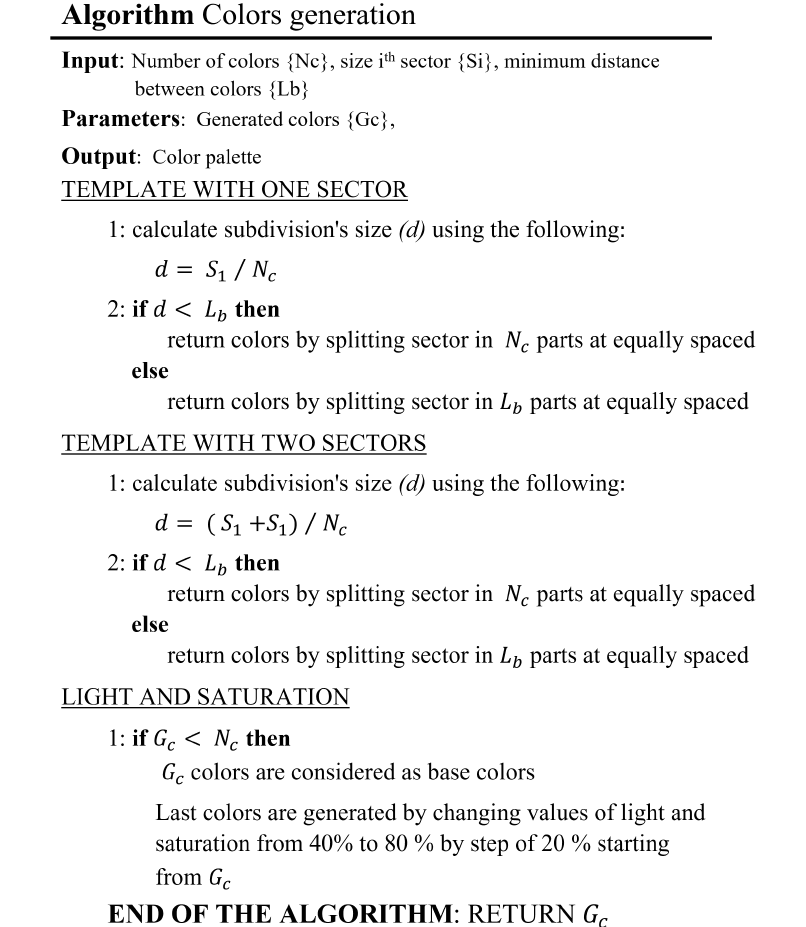
Figure 3. Pseudo-code of the algorithm for generating colors from harmonic